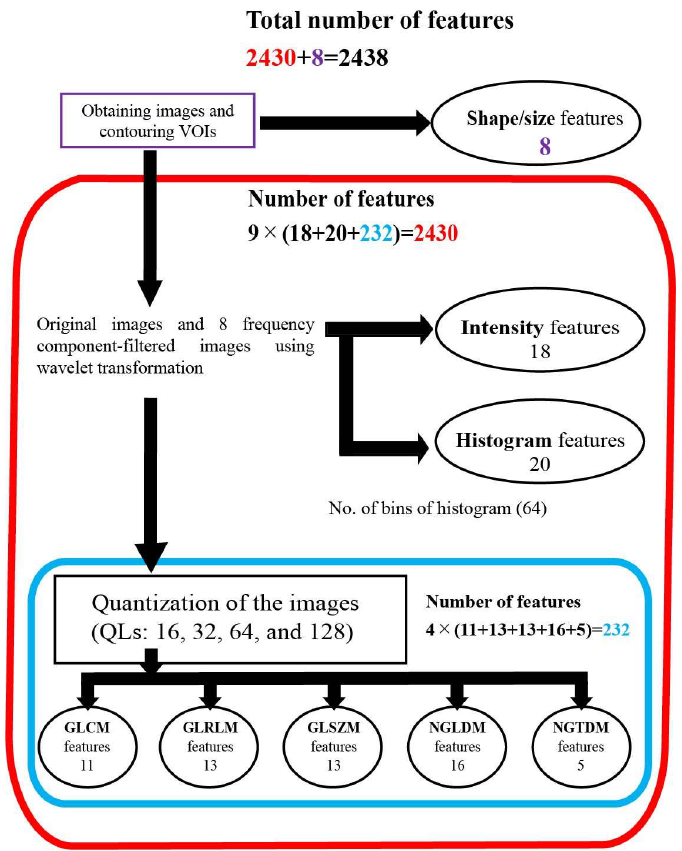
Figure 1. Diagram of features extraction. A total of 2438 features were extracted from each MRI sequence (GdT1 and T2). Abbreviations: quantization levels—QLs; gray-level co-occurrence matrix—GLCM; gray-level run-length matrix—GLRLM; gray-level size-zone matrix—GLSZM; neighboring gray-level dependence matrix—NGLDM; neighborhood gray-tone difference matrix—NGTDM.